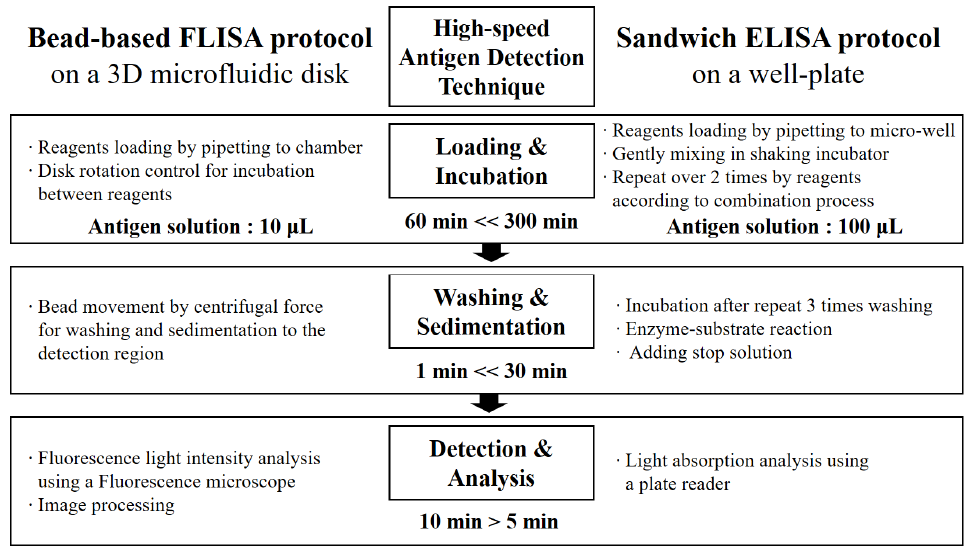
Figure 5. A flow chart comparison of antigen detection techniques between microbead FLISA and traditional sandwich ELISA protocols.